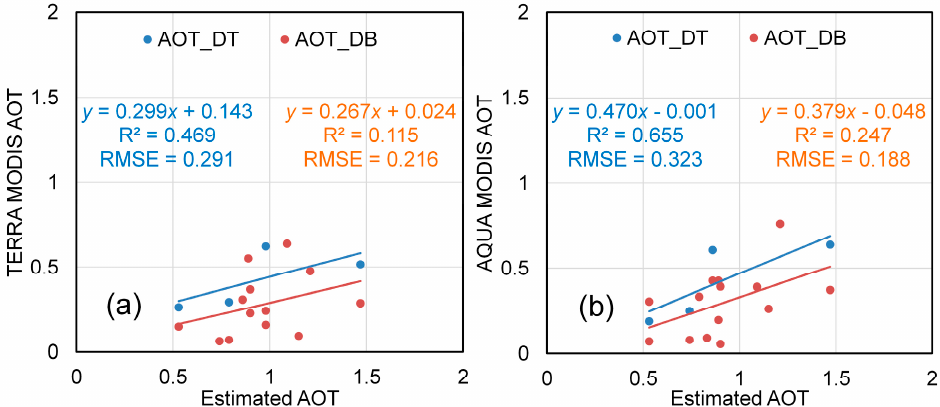
Figure 6. Comparisons of the TERRA-AQUA aerosol retrievals and ( a ) the TERRA MODIS retrievals and ( b ) the AQUA MODIS retrievals. DT represents dark target algorithm and DB represents dark blue algorithm.